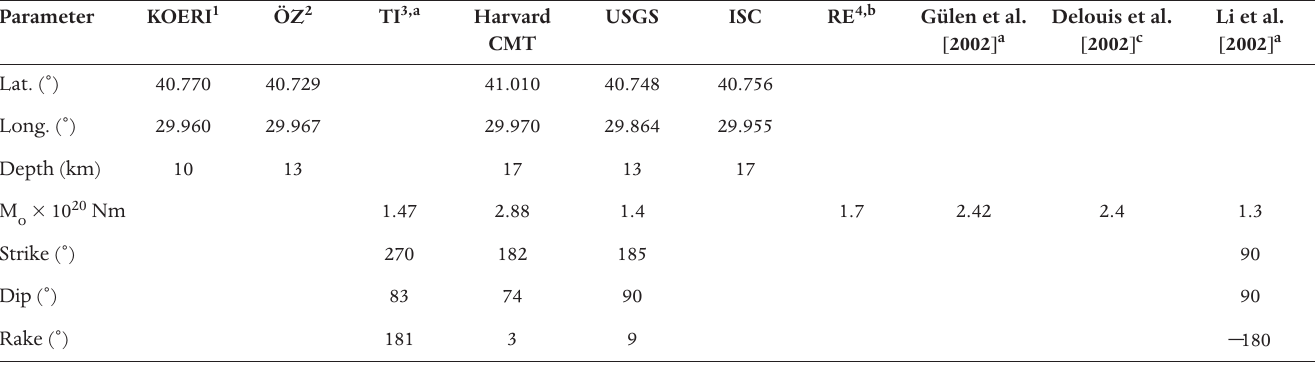
≥ 6.8 earthquakes S